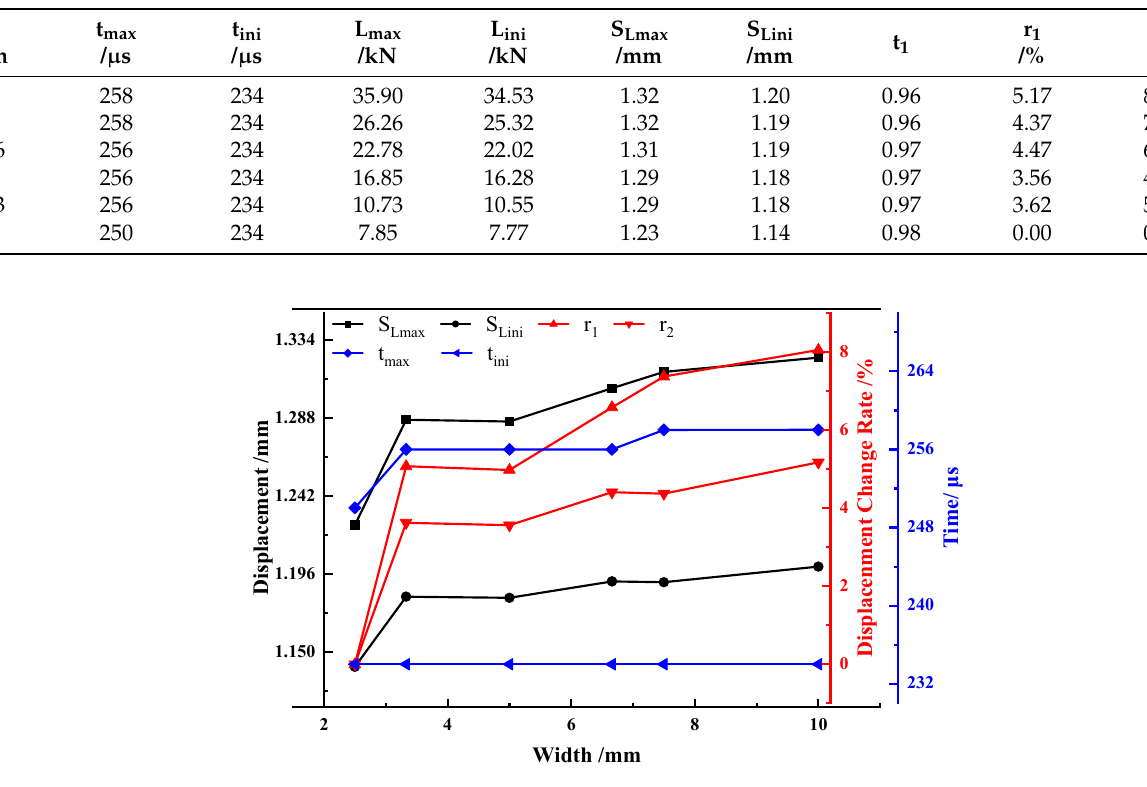
Figure 20. Characteristic time, load and displacement, corresponding ratio, and change rate.